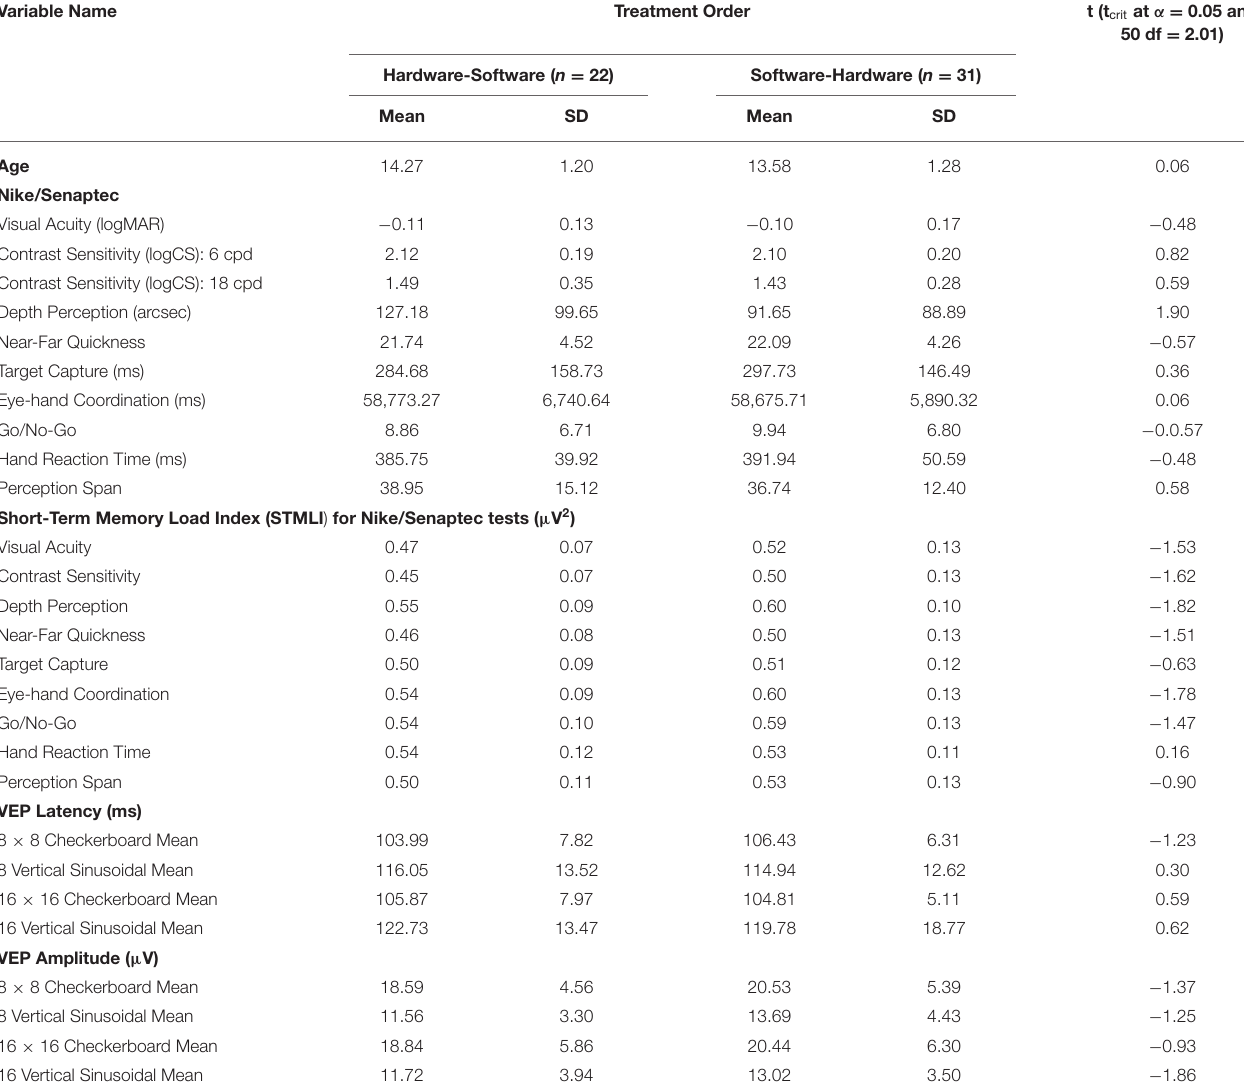
TABLE 1 | Means and standard deviations for dependent variables at baseline as a function of treatment